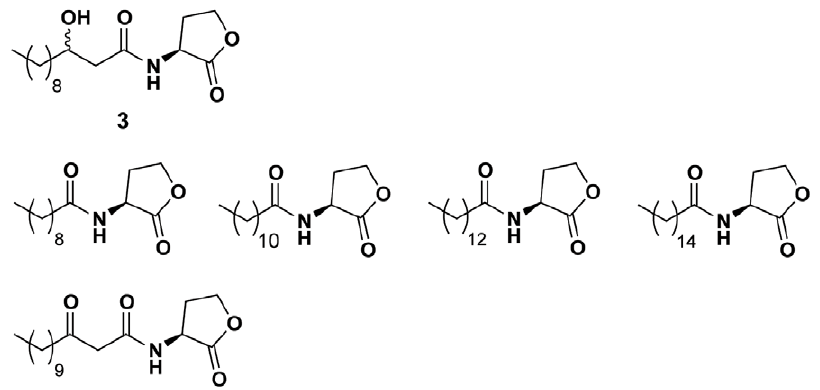
Figure 6. AHLs produced by A.baumannii .